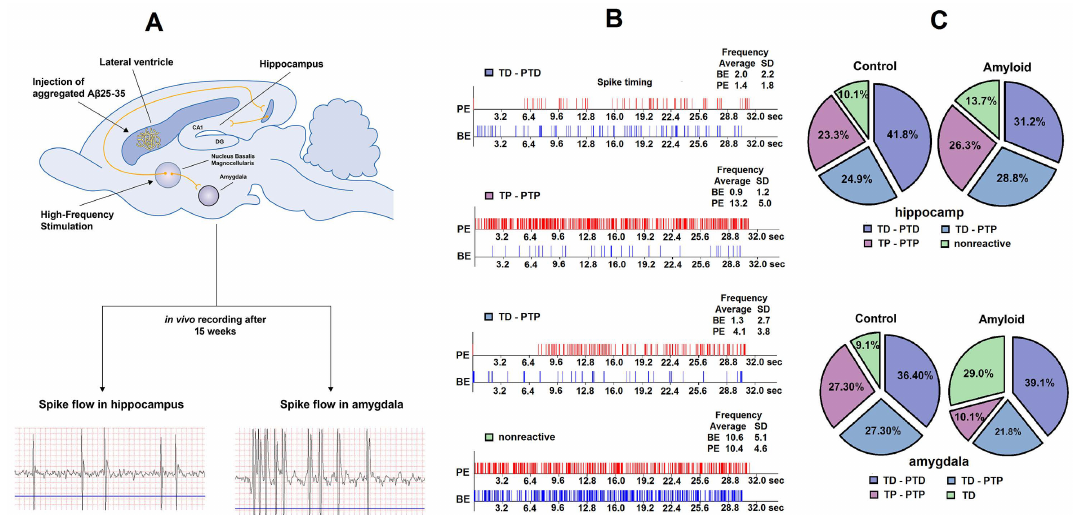
Figure 1. Graphical illustration of the whole electrophysiological experiment. ( A ) Typical example of in vivo recording of spike flow in single hippocampal and amygdala neurons. ( B ) Examples of spike activity of a single neuron: pulse flow in a real-time 30 s before stimulation (BE, before the event) and 30 s after stimulation (PE, post-event). ( C ) The percentage distribution of specific types of responses (tetanic depression-post-tetanic depression (TD-PTD), tetanic potentiation-post-tetanic potentiation (TP-PTP), tetanic depression-post-tetanic potentiation (TD-PTP), and no reactivity) of hippocampus and amygdala neurons to high-frequency stimulation of nucleus basalis magnocellularis in the control and amyloid